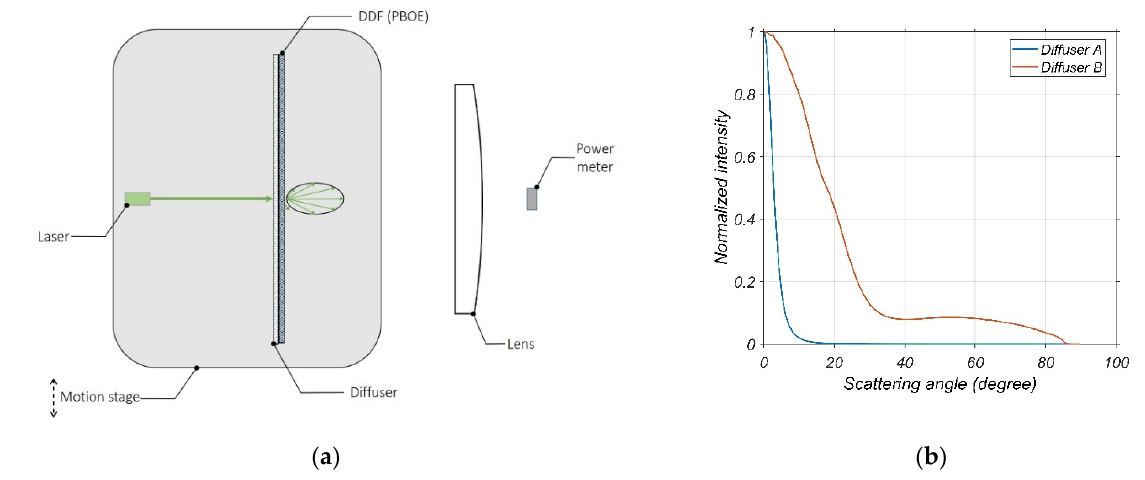
Figure 5. ( a ) Schematic illustration of the experimental setup; ( b ) Scattering angular distributions of the diffusers used in the experiment. Diffuser A represents a directional display, while diffuser B represents a conventional